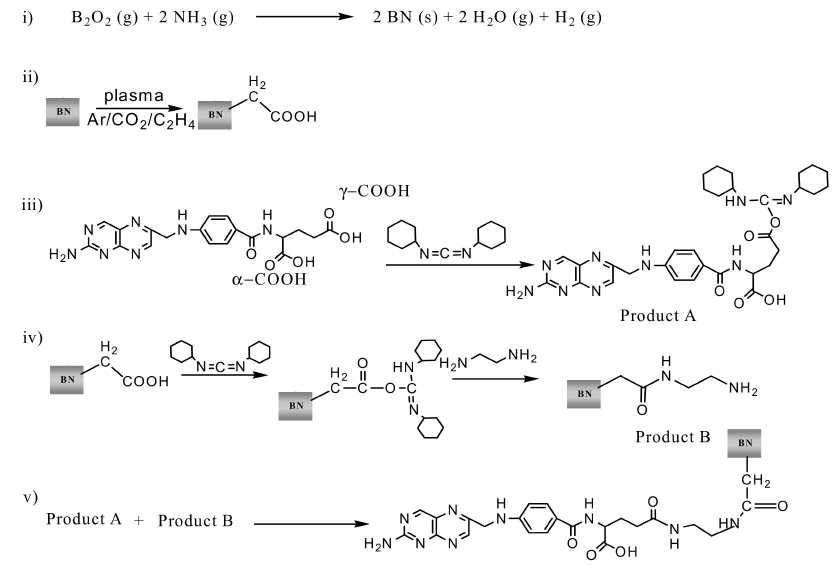
Figure 2. Scheme of BNNP fabrication and subsequent modification: BNNP synthesis using the reaction of boron oxide vapor with ammonia ( i ), plasma polymerization ( ii ), folate acid (FA) activation using DCC ( iii ), fabrication of EDA-BNNPs PT ( iv ), and FA / EDA-BNNPs PT ( v )